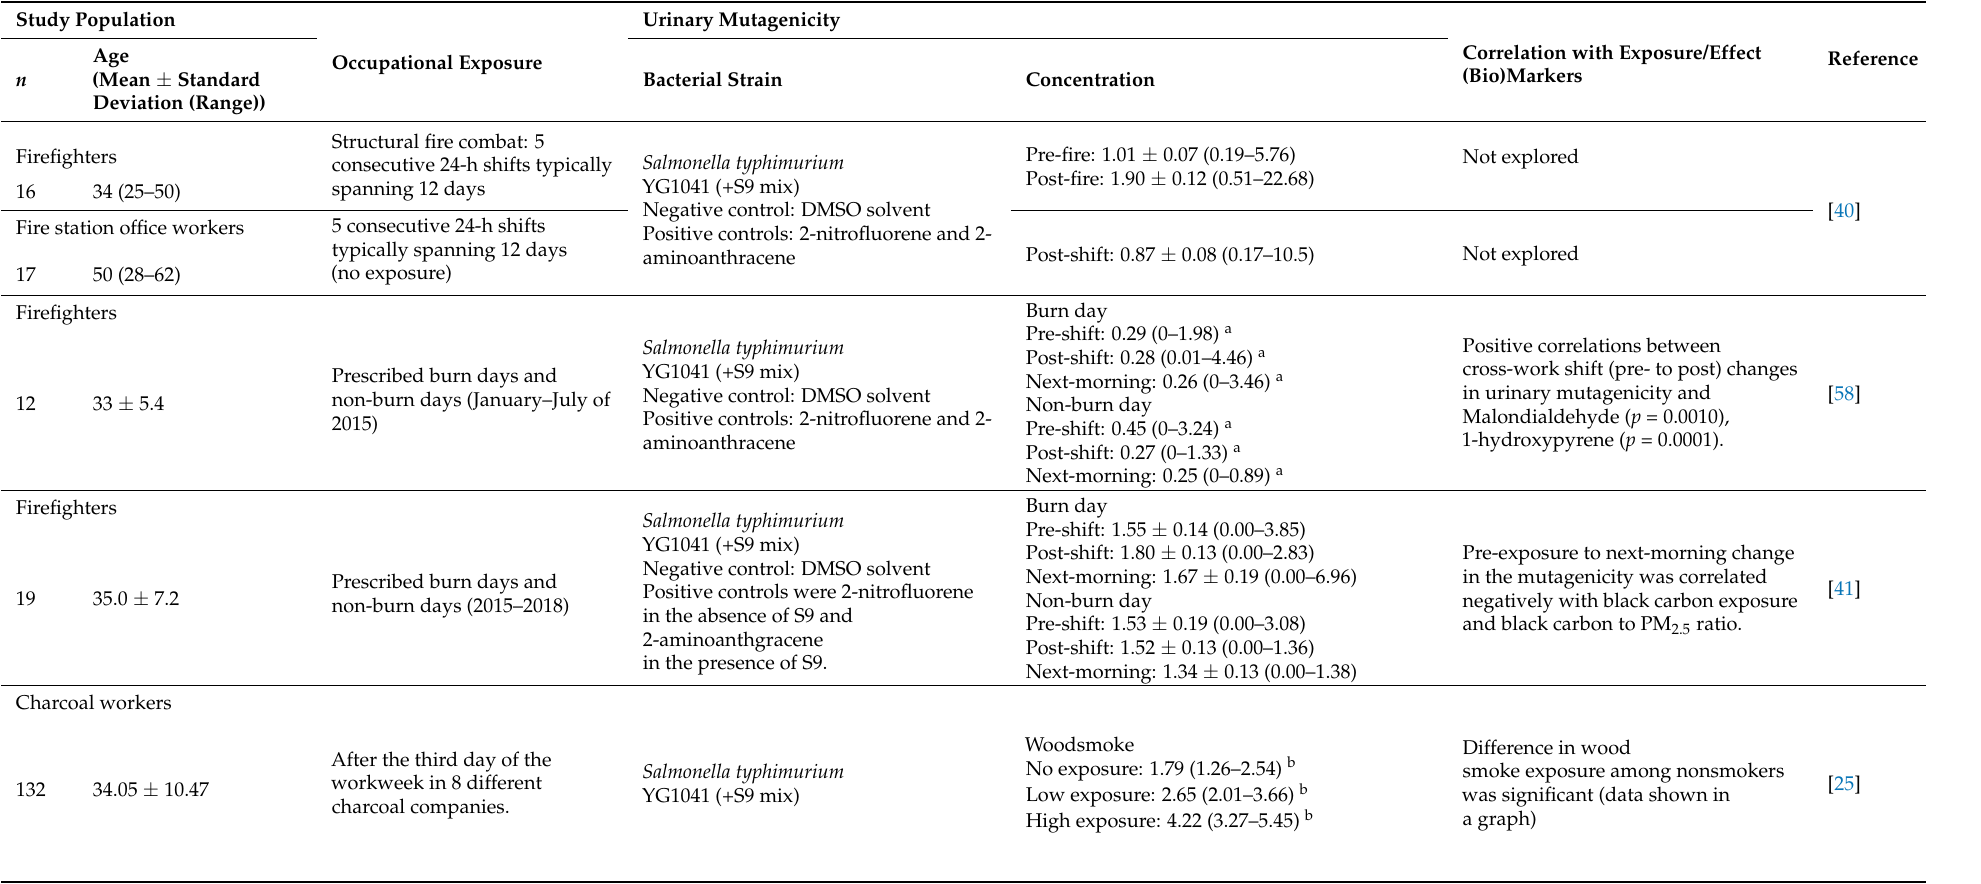
Table 2. Urinary mutagenicity evaluation (revertants/ µ mol creatinine, presented as geometric mean ± standard deviation (range), unless indicated otherwise) in various occupational exposure contexts over the last 20 years